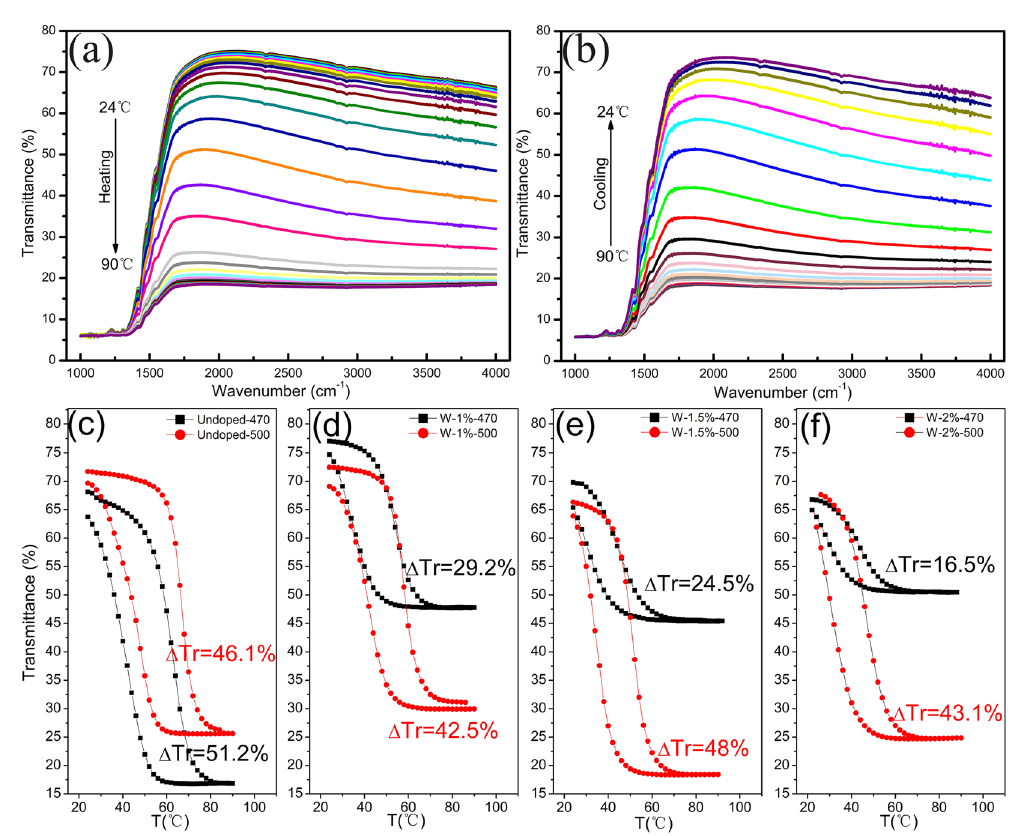
Figure 5. The infrared transmittance curves of the 1.5%W doped samples in the ( a ) heating and ( b ) cooling in the range of 1000–4000 cm − 1 . Hysteresis loops for the temperature dependent transmittance of ( d ) Undoped; ( d ) nominal 1 at.% W doped; ( e ) nominal 1.5 at.% W doped; ( f ) nominal 2 at.% W-doped VO 2 films annealed at 470 and 500